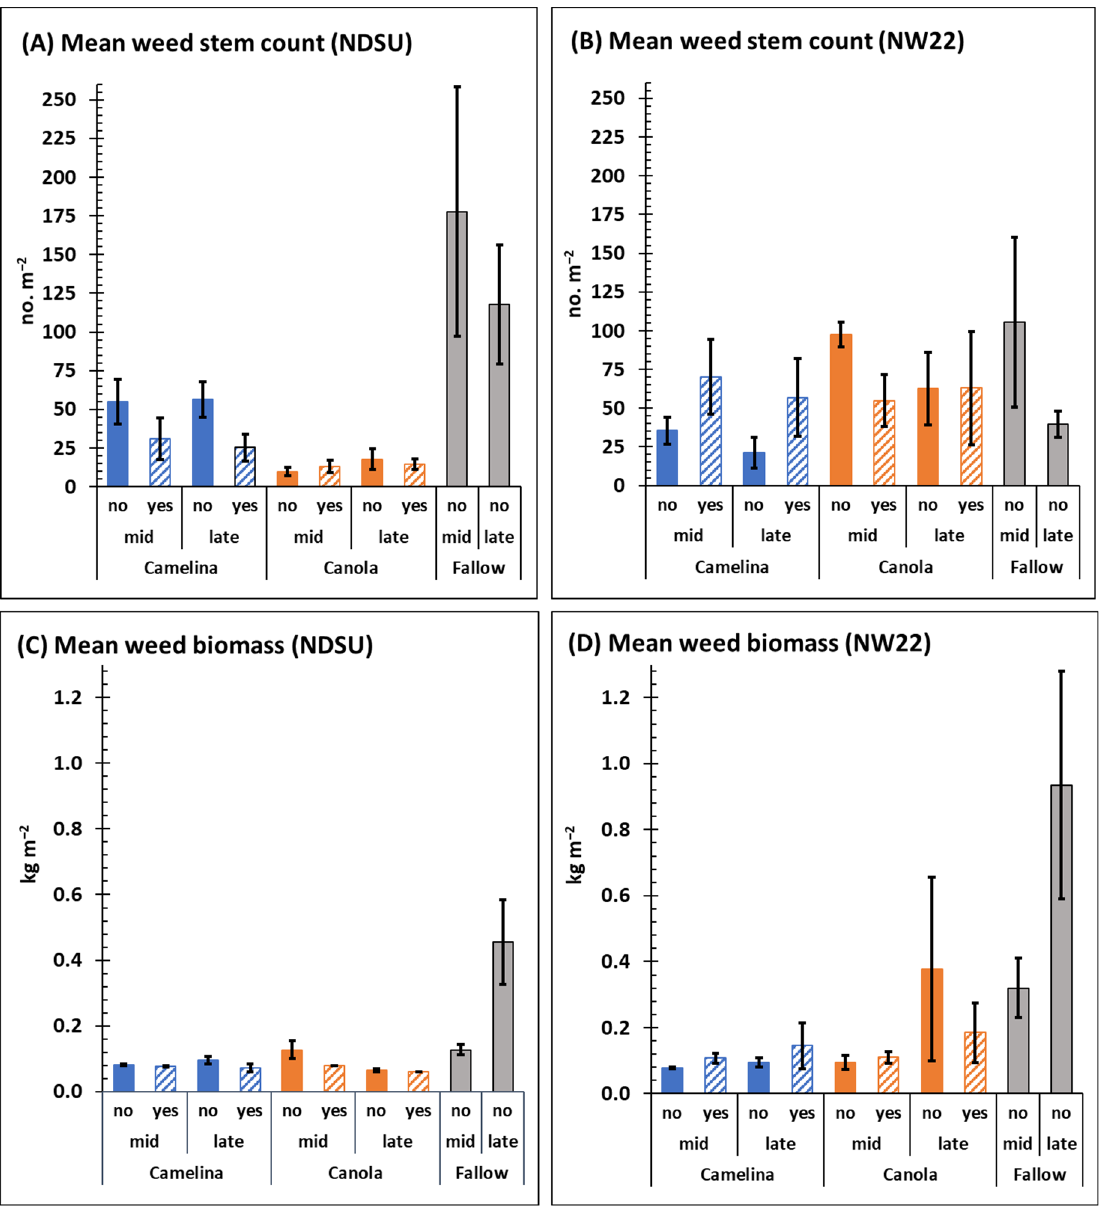
Figure 1. Mean weed stem counts ( A , B ) and biomass dry weights ( C , D ) mid- and late-season from field plots of fallow and sulfonylurea-resistant camelina and canola at NDSU ( A , C ) and NW22 ( B , D ) treated with (yes) or without (no) sulfonylurea. Fallow plots were not treated with sulfonylurea herbicide. Error bars represent the standard error of the mean.